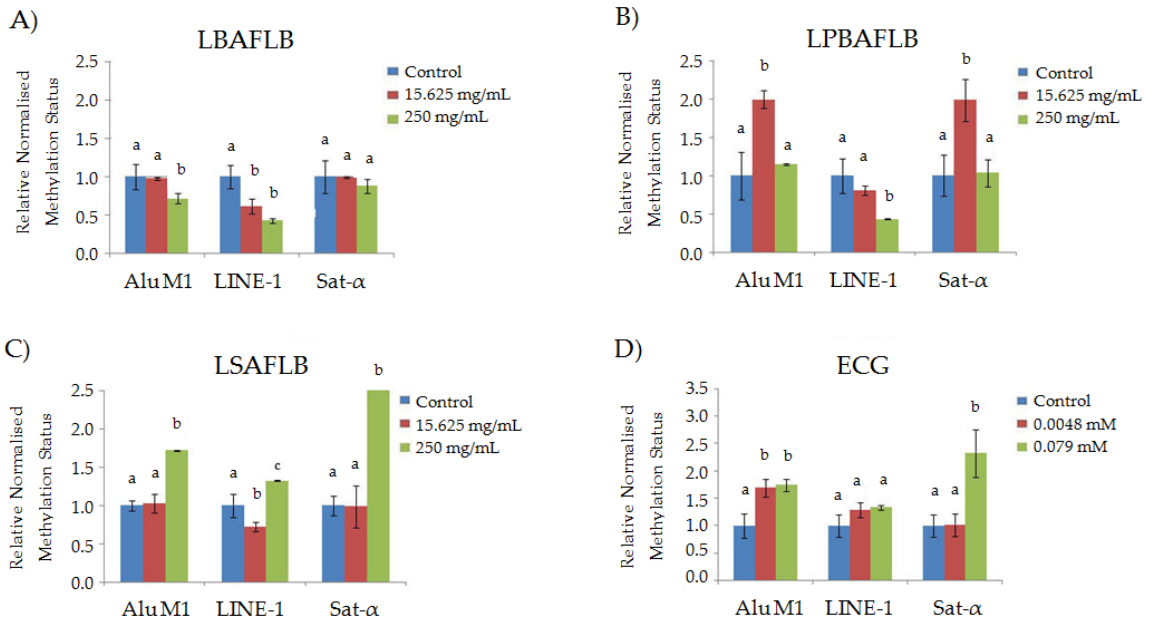
Figure 6. Relative normalised expression data of each repetitive element in treated HL-60 cells with different concentration of lyophilised blond alcohol-free lager beer (LBAFLB) ( A ), lyophilised pale-blond alcohol-free lager beer (LPBAFLB) ( B ), lyophilised stout alcohol-free lager beer (LSAFLB) ( C ) and epicatechin gallate (ECG) ( D ). The different letters (a, b and c) in each compound and each repetitive element indicate differences compared to the negative control (a) (ANOVA followed by post hoc Tukey’s